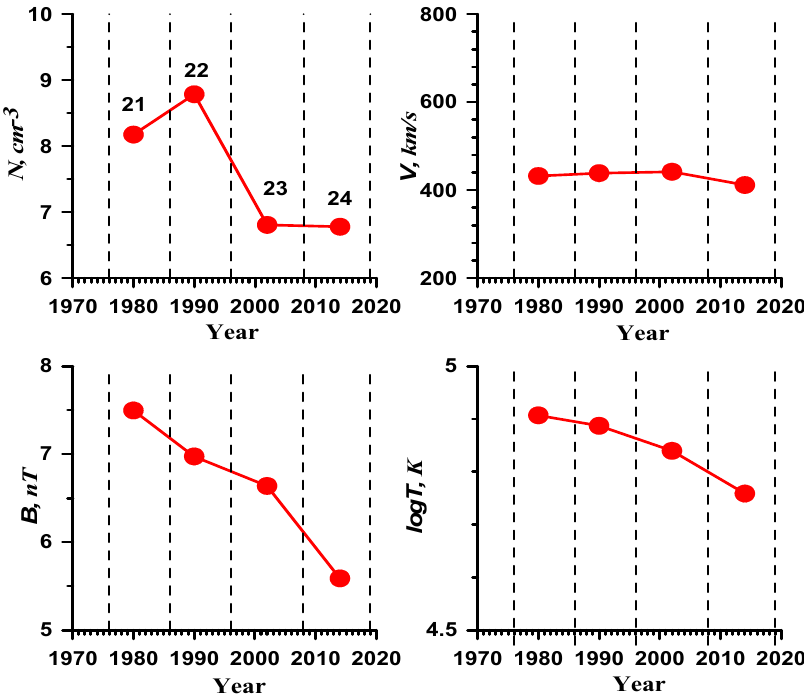
Figure 3. Temporal profiles of yearly averaged density (N), velocity (V), magnitude IMF (B) and proton temperature (T) during solar cycles 21–24.